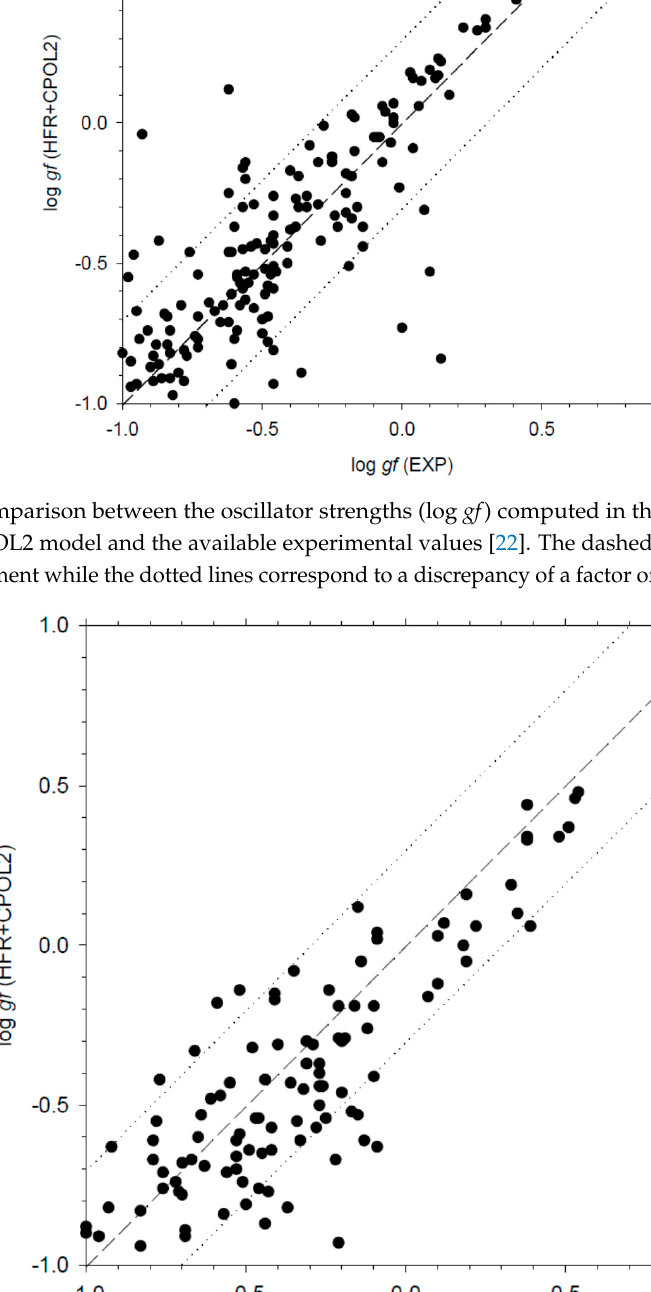
Atoms 2019 , 7 , x FOR PEER REVIEW